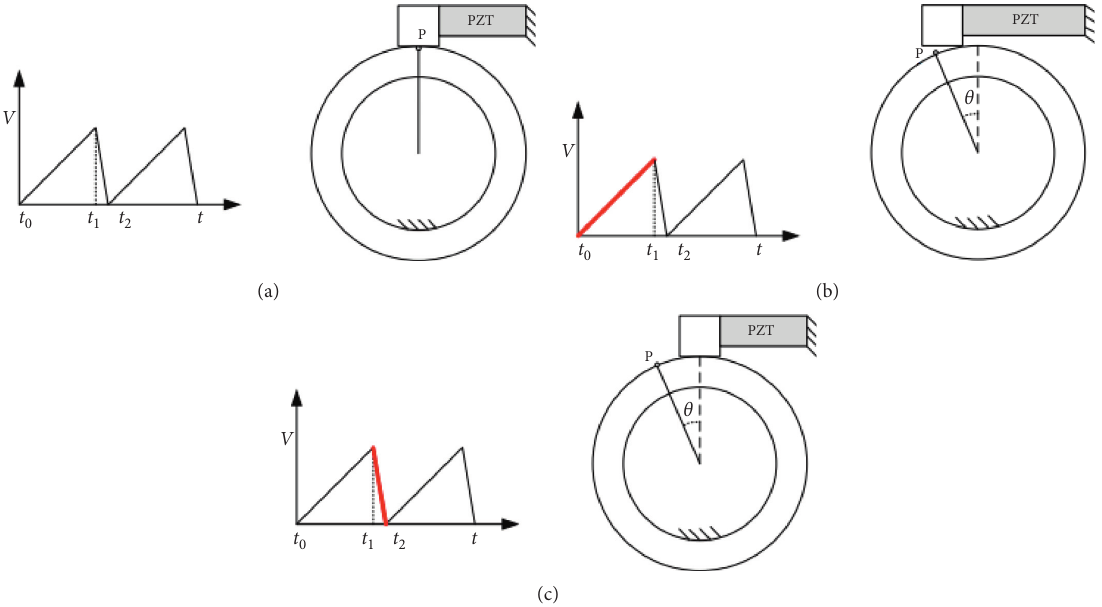
Figure 2: The operating principle.